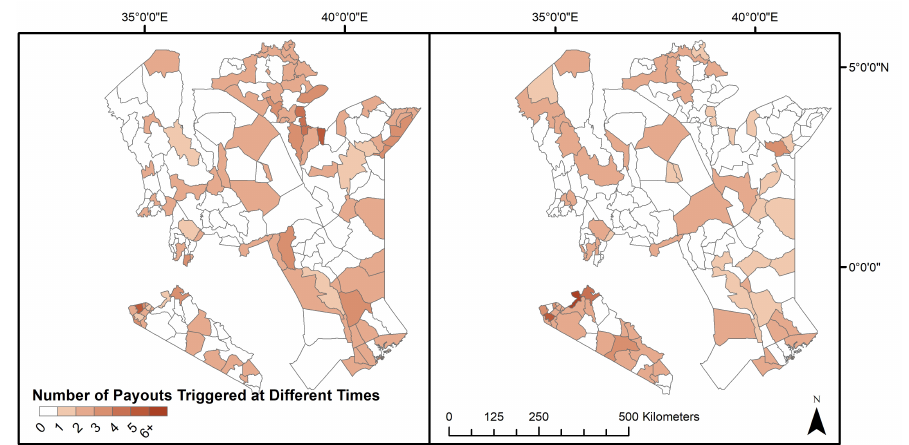
Figure 8. Number of times one product triggered a payout and the other did not for long rains ( right ) and short rains ( left ) from